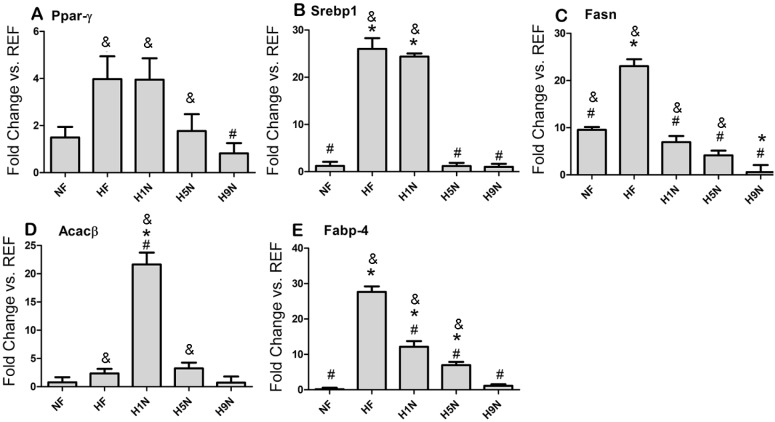
Different maternal diet intervention differentially affected the expression of genes involved in adipogenesis and lipid transportation.(A-E)The adipose tissue expression of Ppar-γ, Srebp1, Fasn, Acacβ, and Fabp4 was measured by real-time PCR. The expression level was normalized against the REF group. Data is reported as Mean±SEM, n = 3–5. The “*” symbol indicates P<0.05 versus the NF group. The “#” symbol indicates P<0.05 versus the HF group. The “&” symbol indicate P<0.05 versus the REF group.